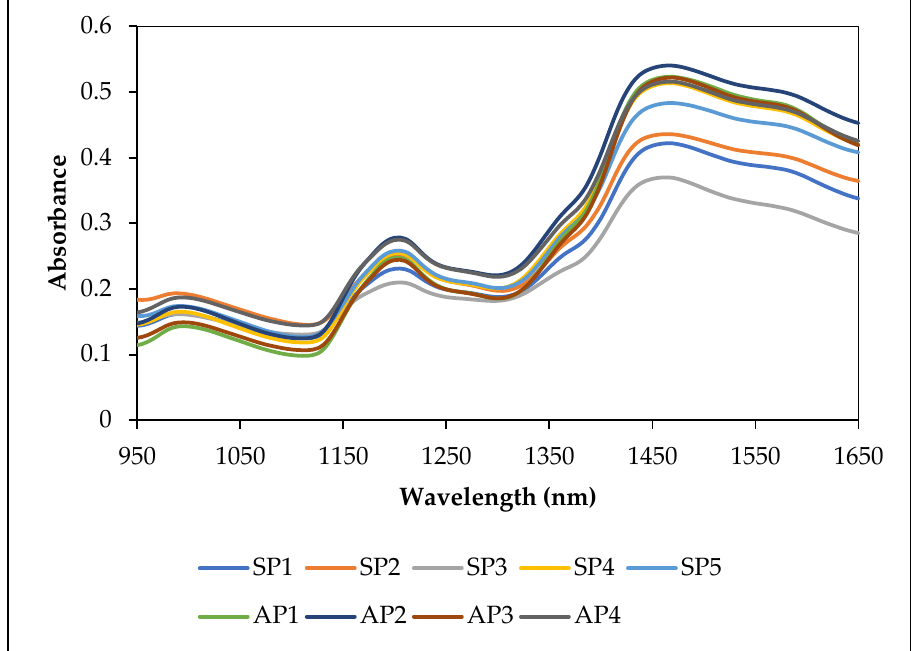
Figure 1. NIR spectra of some intact grain samples from populations used for starch and amylose calibrations.